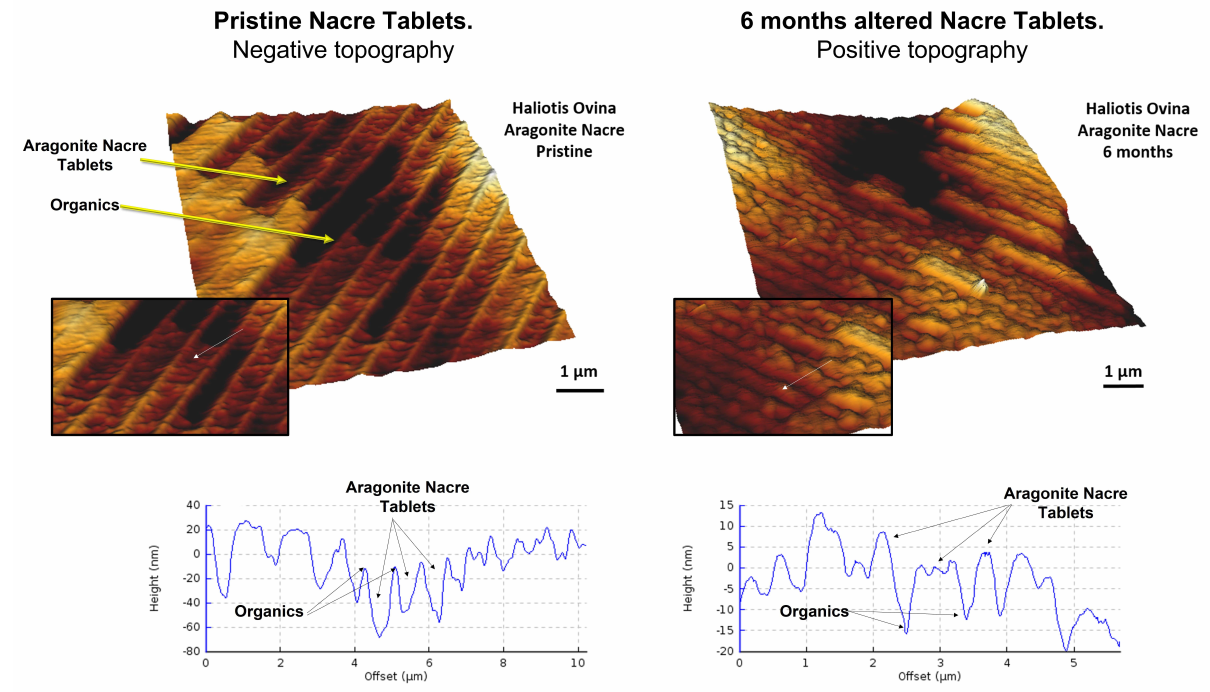
Figure 5. Three-dimensional surface reconstruction of height AFM measurements of aragonitic nacre tablets for (a) pristine and (b) altered shell segments of the gastropod Haliotis ovina . In the pristine shell, the organic membranes that separate adjacent tablets have a positive relief, while in the altered shell analogue a dramatic structural change is observable. At the site of the organic membrane we find a depression.